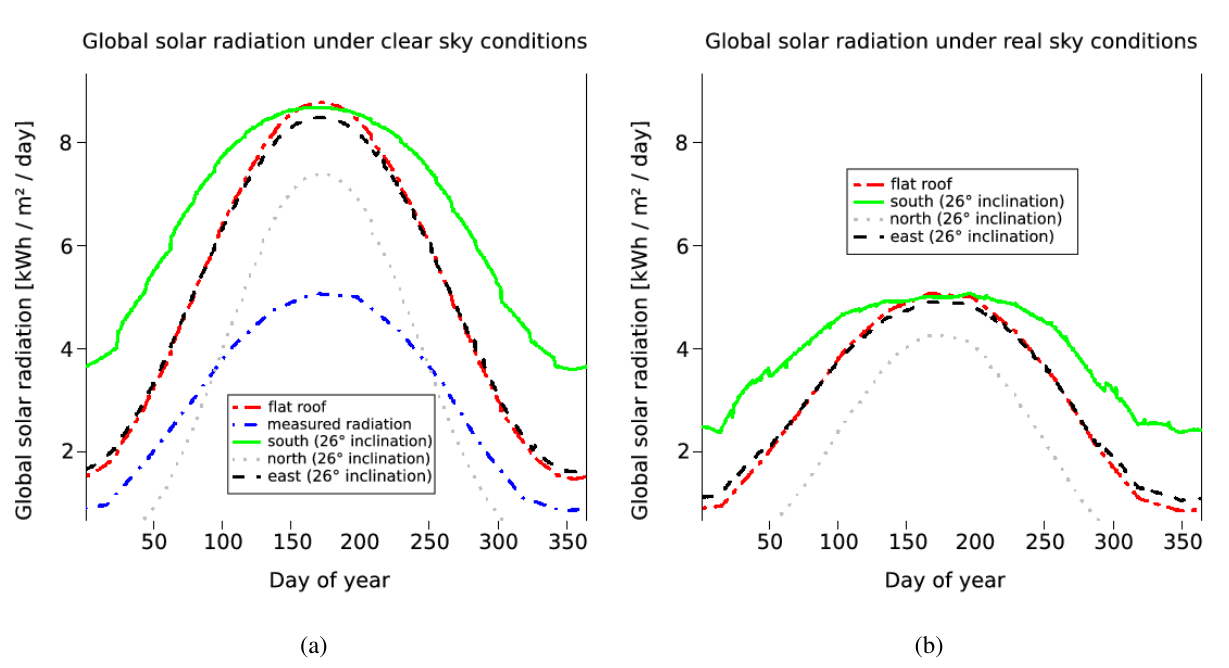
Figure 9. Distribution of the global solar radiation over the course of the year under clear sky (a) and under real sky (b)